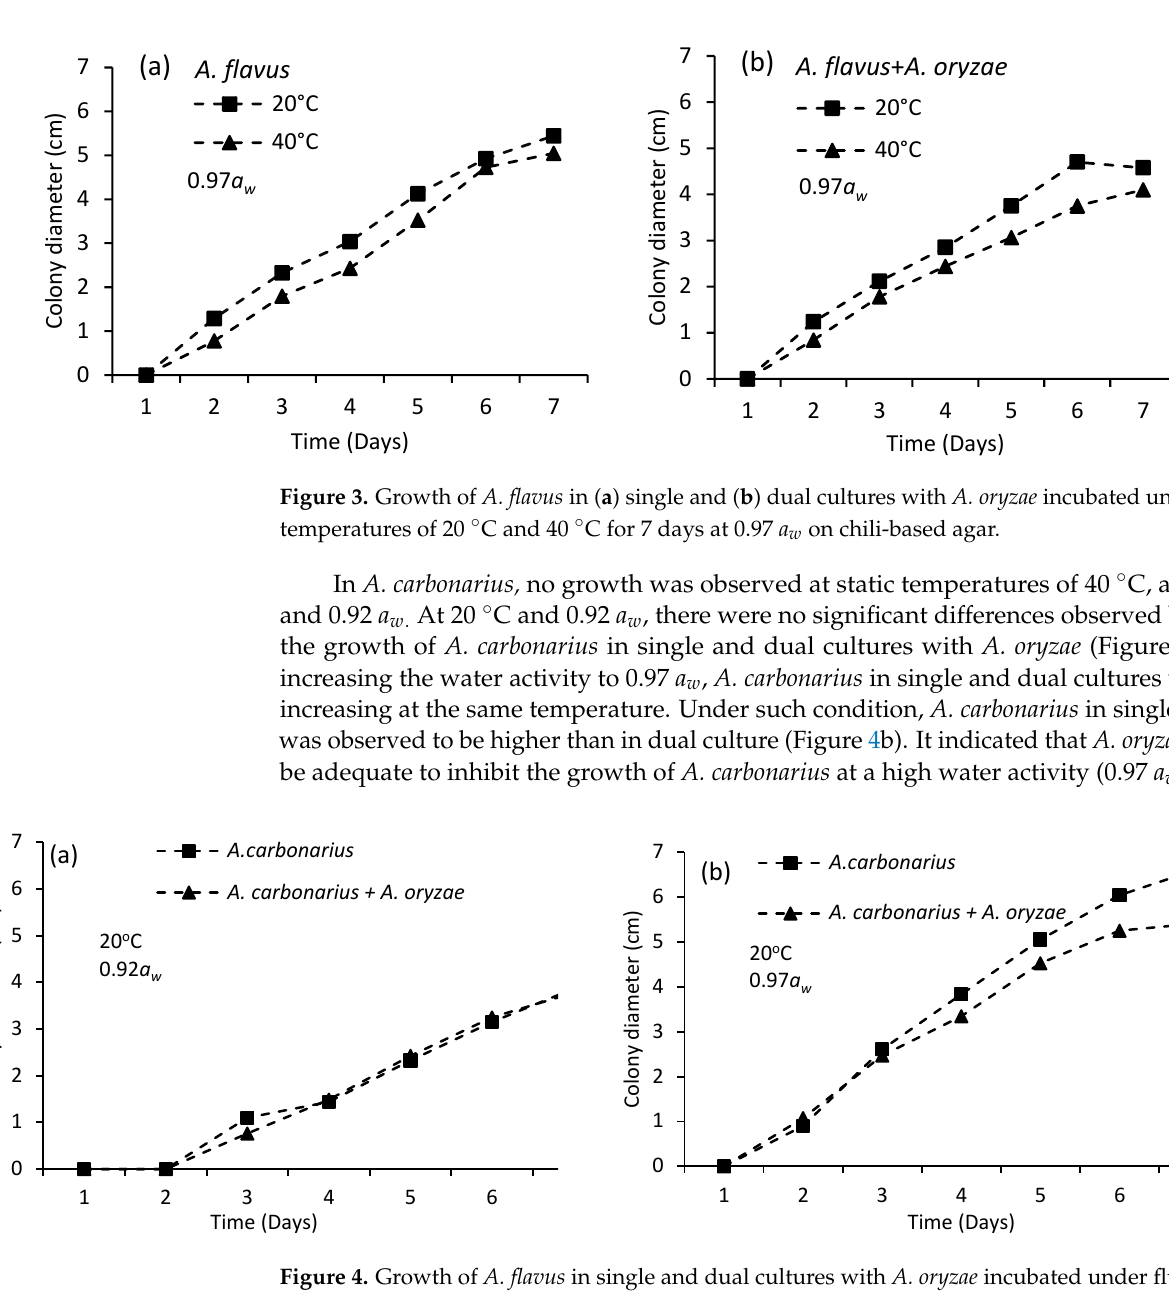
Figure 2. Growth of A. flavus in ( a ) single and ( b ) dual cultures with A. oryzae incubated under static